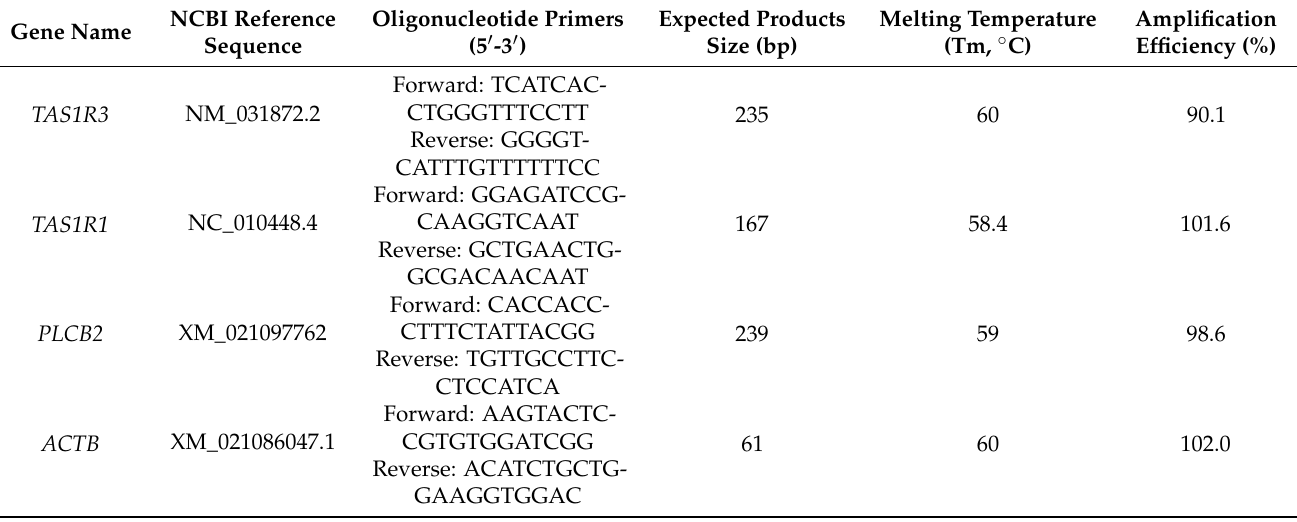
Table 1. The primers for